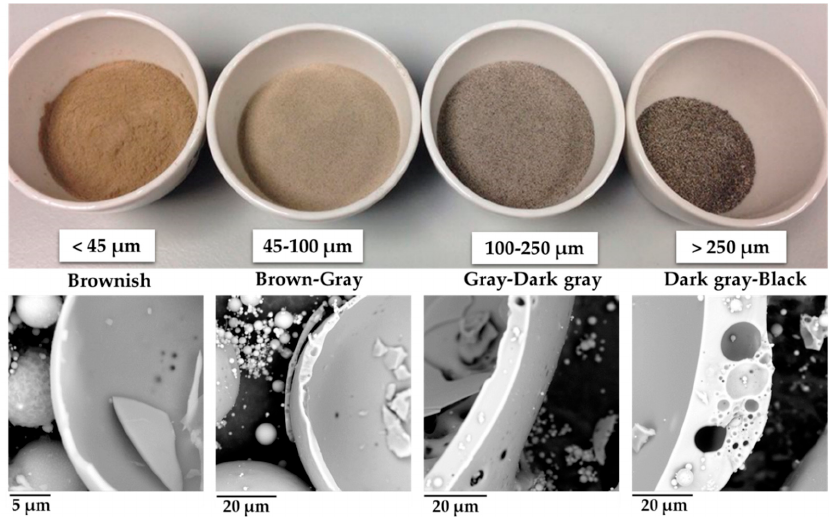
Figure 2. The bulk cenospheres were collected by sink-float method, using a fly ash-to-water ratio of 1:10. Shell thicknesses of those cenospheres in each size range were depicted.